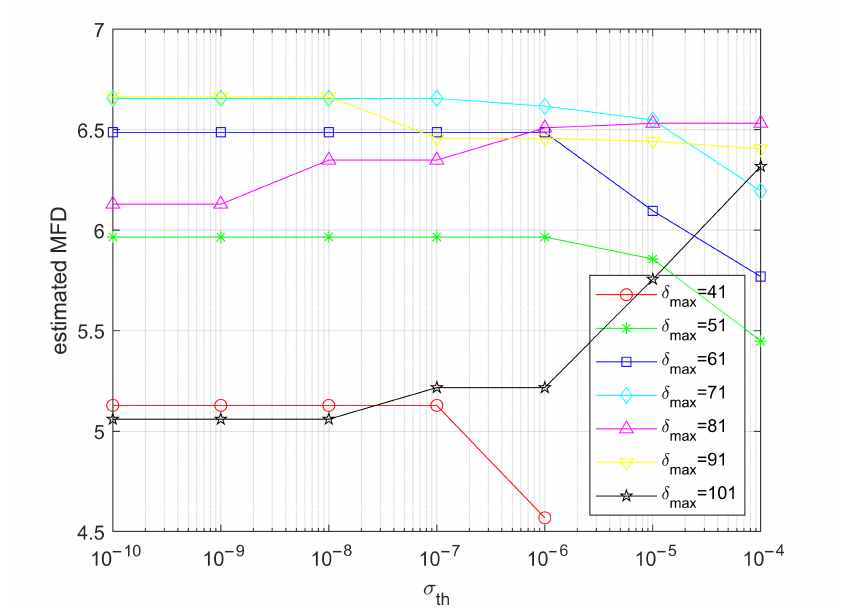
Figure 15. The estimated multi-spectral fractal dimension as a function of σ th for the high generated complexity ( H = 0.1) multi-spectral fractal